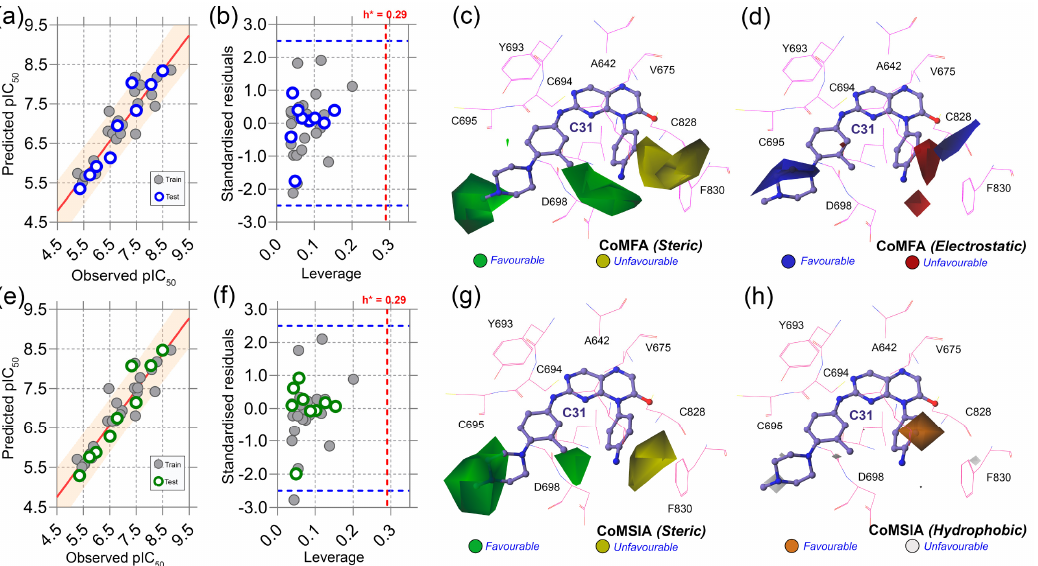
Figure 4. Correlation plots, applicability domain, and contour maps analysis. ( a ) PLS regression plot, ( b ) Williams plot, ( c ) steric contours, and ( d ) electrostatic contours from CoMFA analysis. ( e ) PLS regression plot, ( f ) Williams plot, ( g ) steric contours, and ( h ) hydrophobic contours from CoMSIA analysis. Warning leverage (h*) is shown as red dashed lines in each AD plot. In steric maps, the green and yellow contours indicate that bulky groups are favored and unfavored. On the electrostatic map, blue and red indicate a favorable space for the electropositive and electronegative groups. The orange and light gray color in the hydrophobic map represents favorable and unfavorable substitutions for hydrophobic chemical groups.